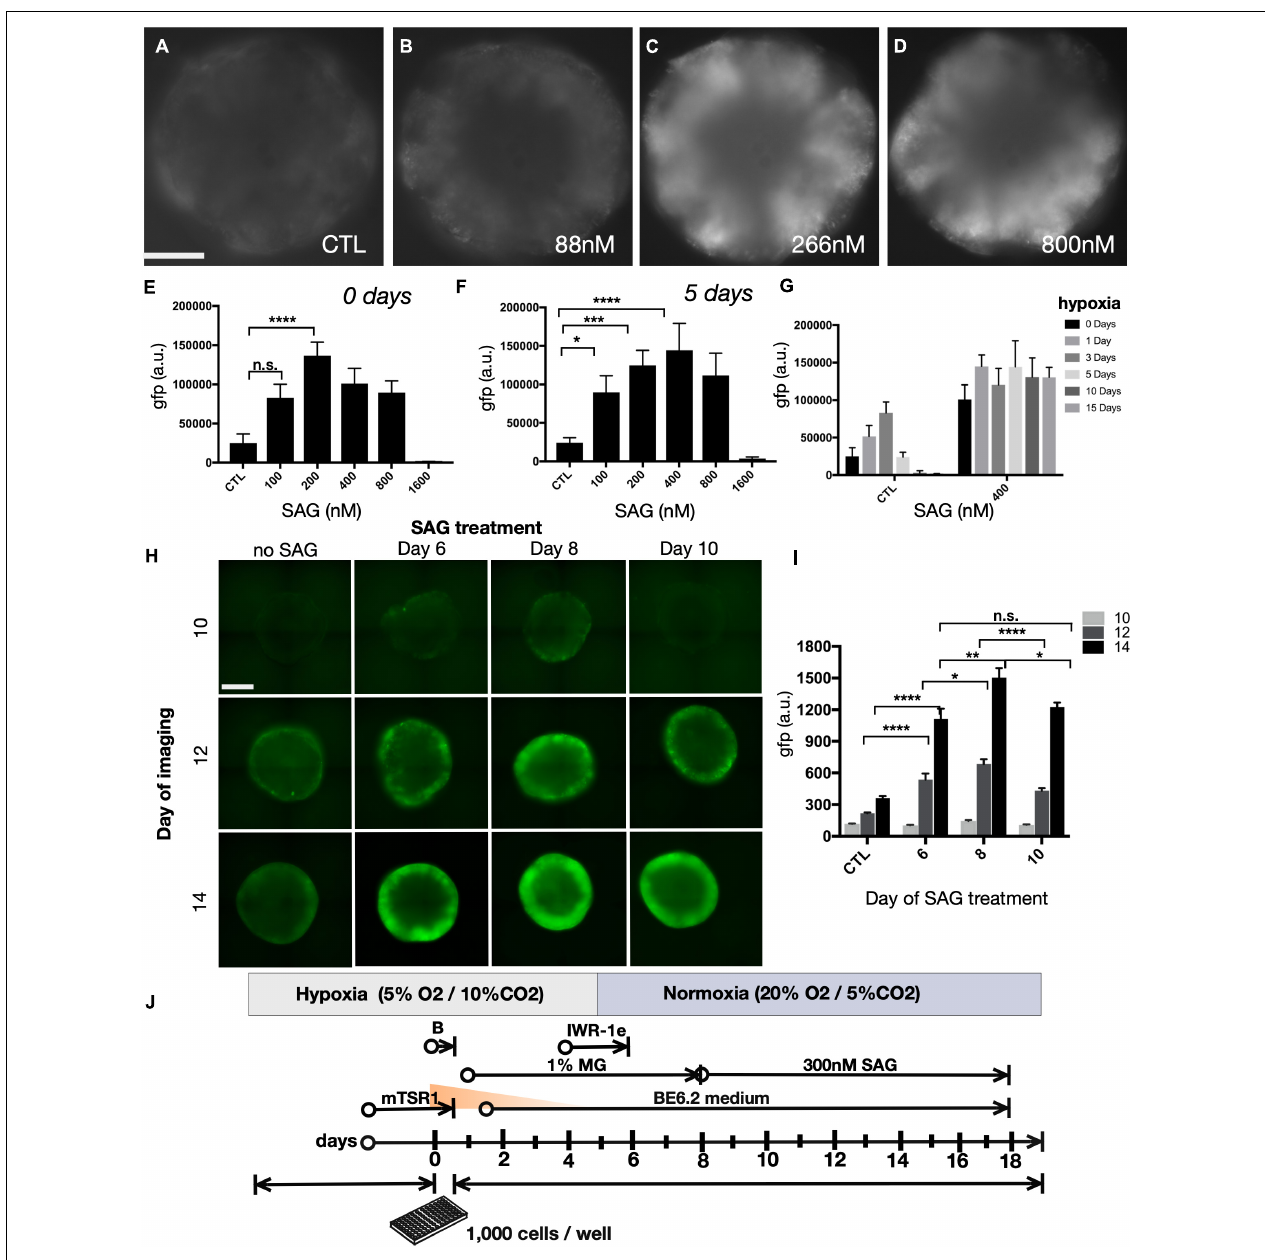
FIGURE 4 | The effect of Shh agonist on SIX6-GFP expression during prolonged hypoxia. (A–D) Widefield images of SIX6-GFP fluorescence at day 15 in live organoids following treatment with smoothened agonist (SAG) up to 800 nM. (E–G) Fluorescence intensity measurements following treatment with an extended range of SAG up to 1600 nM. (E,F) The right side of the parabolic curve at the upper range of treatment reflects the inhibitory action of SAG at high concentrations ( n = 12; 72 total). (G) SIX6-GFP fluorescence measurements at day 15 in control (untreated) and 400 nM SAG treated organoids exposed to varying lengths of hypoxia (0, 1, 3, 5, 10, and 15 days; n = 12; 72 total). (H) Fluorescence microscopy of live organoids at days 10, 12, and 14 following SAG treatments initiated at 6, 8, or 10 days and (I) their corresponding fluorescence intensity measurements ( n = 15; 180 total). (J) Summary of optimized conditions for optic vesicle formation. Statistical significance determined by one-way ANOVA; gfp a.u. = GFP arbitrary unit; * = statistically significant ( p < 0.05), ** = statistically significant ( p < 0.01), *** = statistically significant ( p < 0.001), **** = statistically significant ( p < 0.0001), n.s. = not significant. Scale bars = 300 µ m.